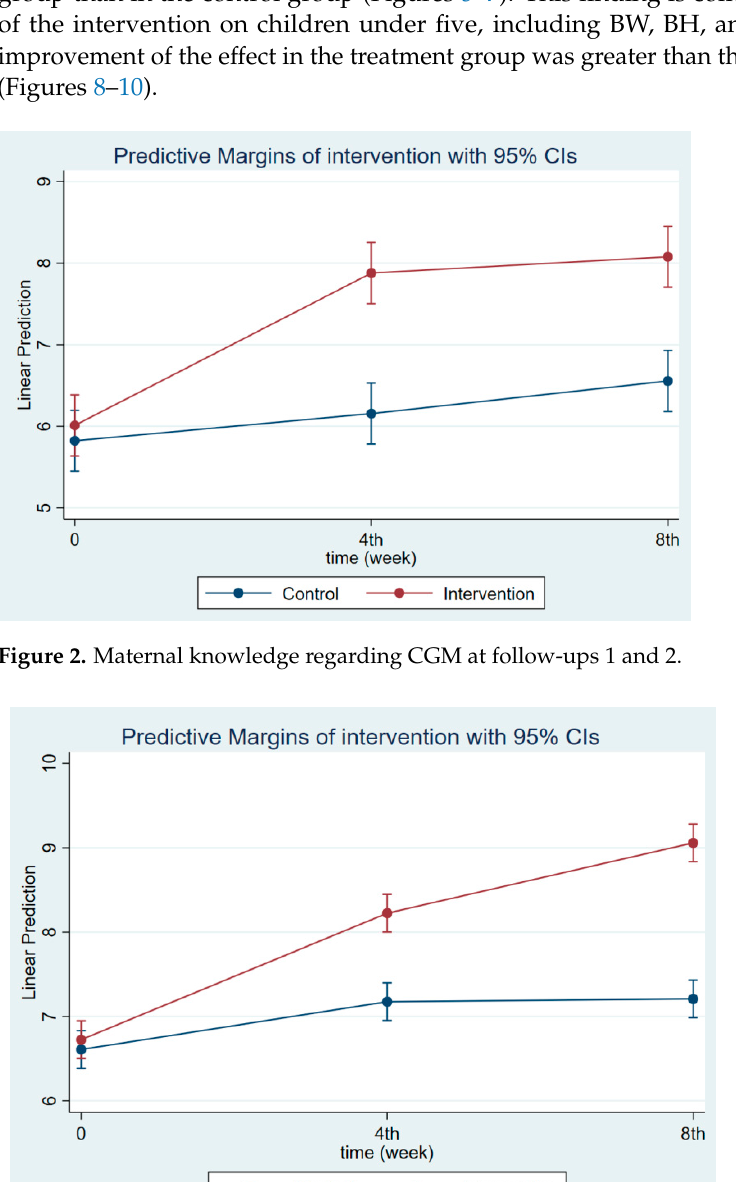
Figure 4. Maternal knowledge regarding IYCF at follow-ups 1 and 2. Figure 5. Maternal practice regarding CGM at follow-ups 1 and 2.